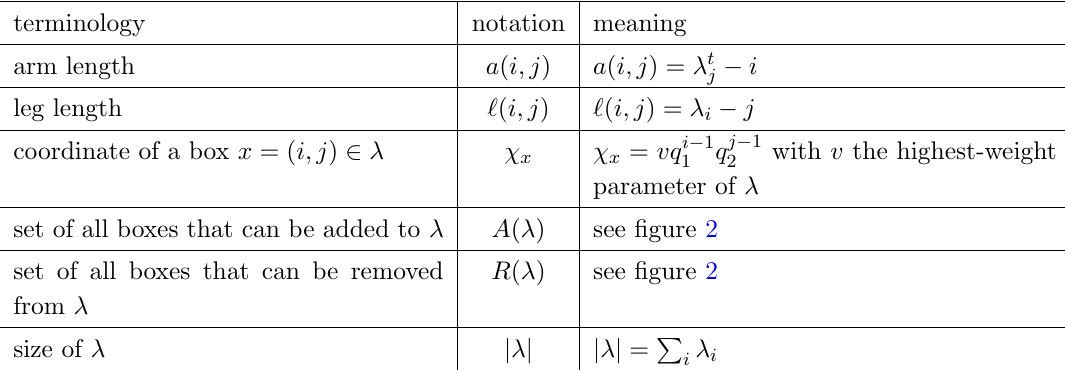
Figure 1 . The elliptic genus, which can be computed from the topological formalism on a com- pacti(cid:12)ed toric diagram, can alternatively be obtained with the elliptic vertex applied to the toric diagram without compact directions.